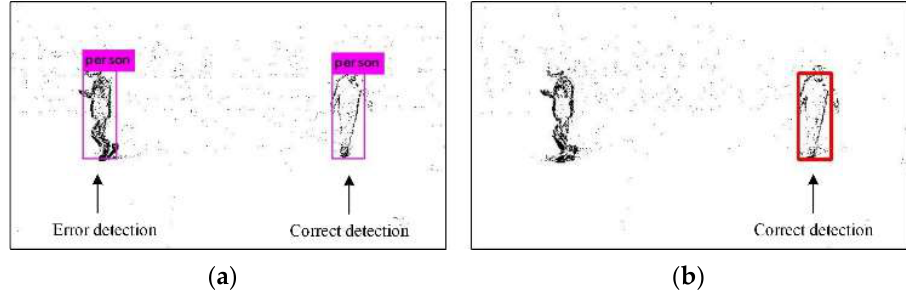
Figure 15. Comparison of event frame-based detection and combined detection based on color. ( a ) Event frame detection, ( b ) Combined detection based on color.